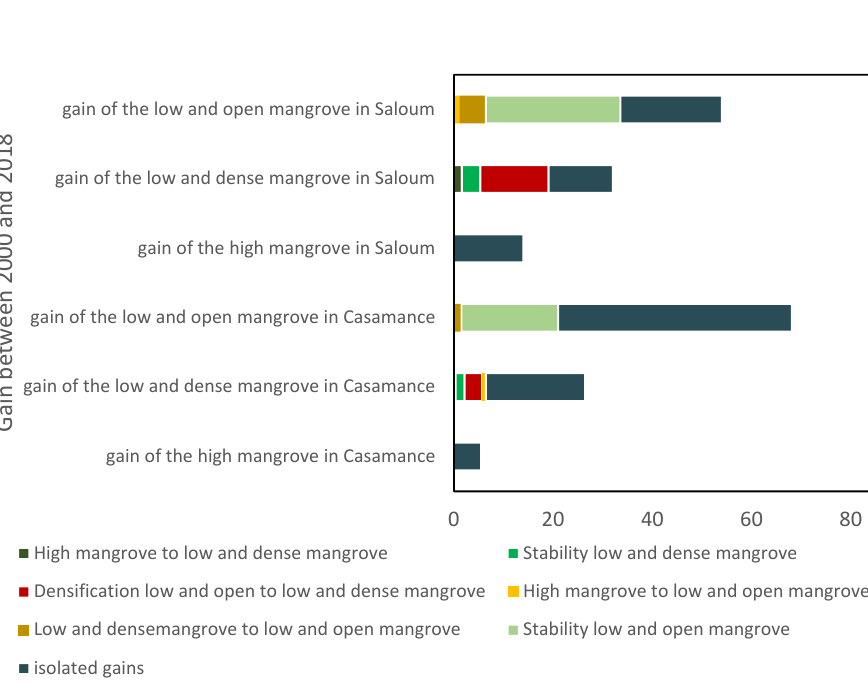
Figure 9. Contribution of the dynamics to the contiguous diffusion of the mangrove areas (the proportions and contributions were evaluated and calculated relative to the total surface areas of the gains, respectively, in the Saloum and Casa- mance mangroves).